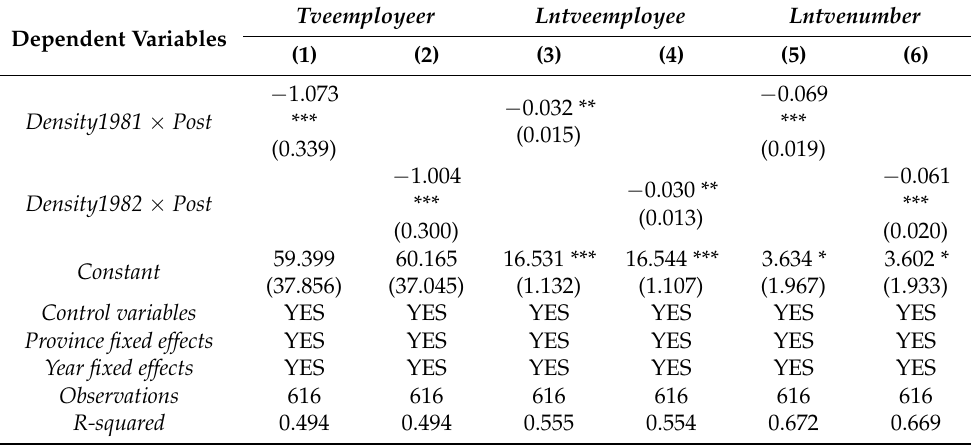
Table 7. Robustness tests: replace the indicator of historical endowment conditions for the develop- ment of